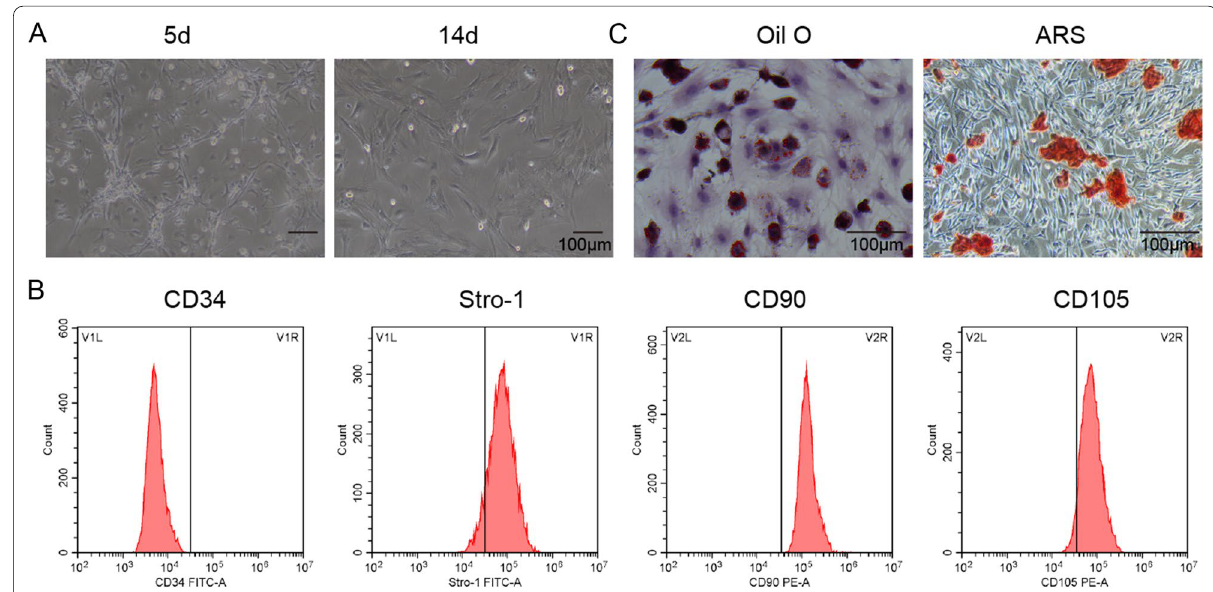
Fig. 1 The isolation, culture and identification of ADSCs. A An inverted microscope was used to observe the morphology of ADSCs (scale bar: 100 μm). B Flow cytometry was carried out to assess the surface marker antigens on ADSCs. C Differentiation potentials of ADSCs were assessed by Alizarin Red S staining and Oil Red O staining (scale bar: 100